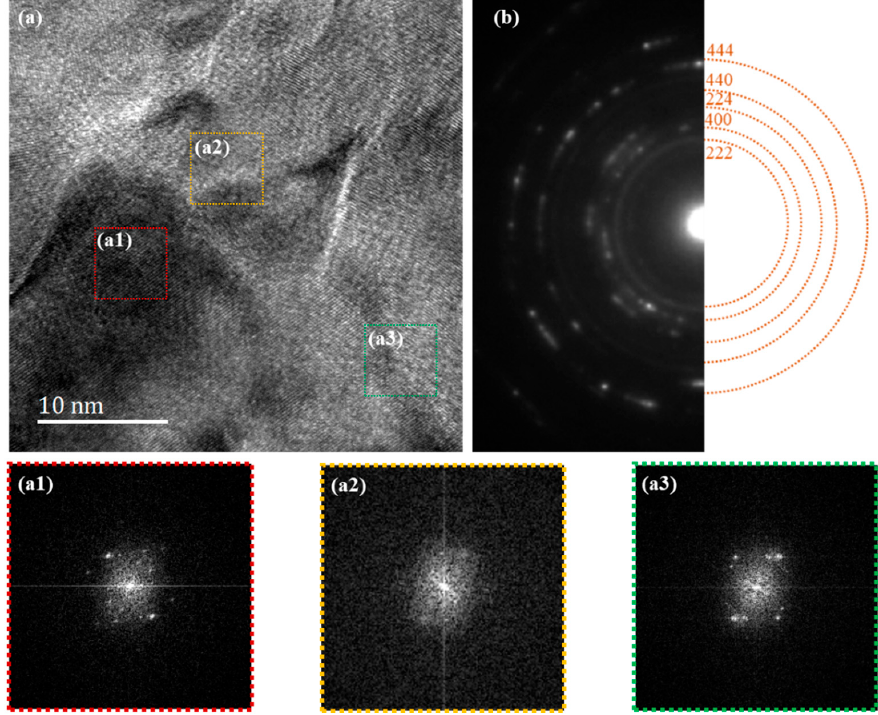
Figure 5. ( a ) The high-resolution TEM micrographs of the 90% rolled specimens annealed at 630 K for 1 h with the FFT diffraction patterns of the regions a1 (nanocrystal), a2 (amorphous), and a3 (nanocrystal), and ( b ) SADPs compared with that of general Fe 3 Pd FCC crystal.